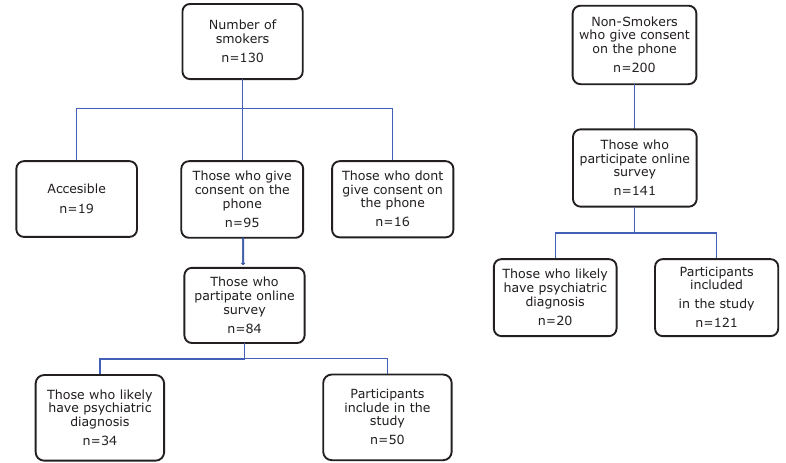
Figure 1. Flowchart of participant